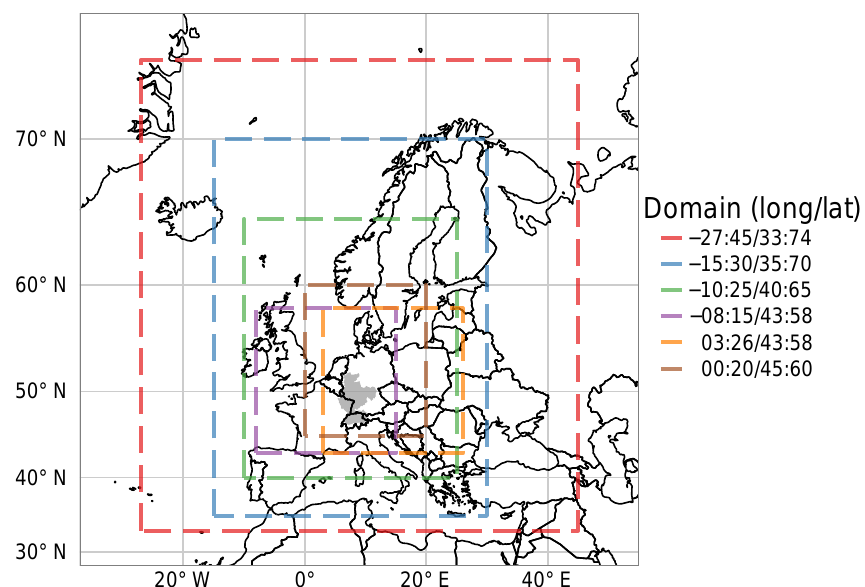
Figure 2. Spatial domains of weather pattern classifications in degree of geographic longitude/latitude. The dark grey polygon shows the location of the Rhine catchment. Domain 3 : 26 / 43 : 58 as in Philipp et al. (2010), region D07; − 15 : 30 / 35 : 70 as in Nied et al. (2014).